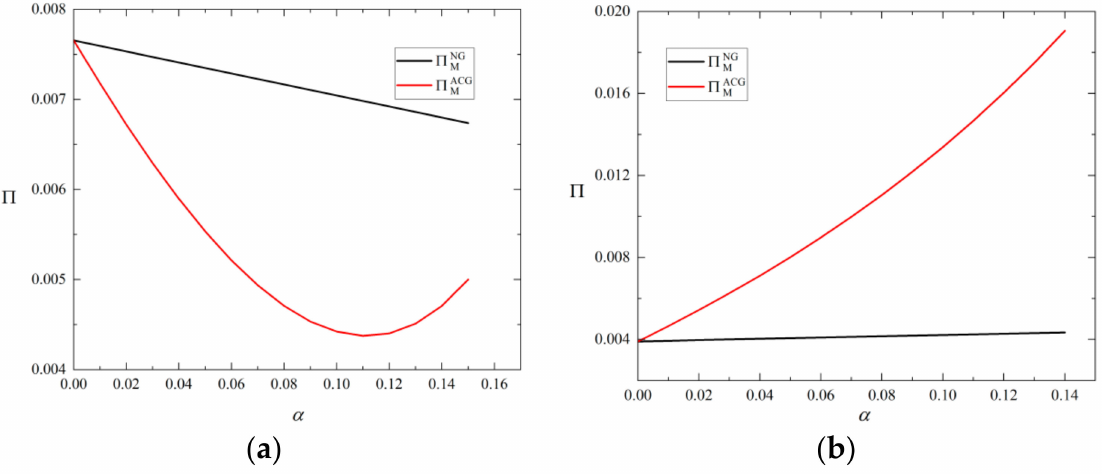
Figure 6. Profit of the manufacturer under Models NG and ACG. ( a ) c n = 0.45,( b ) c n =